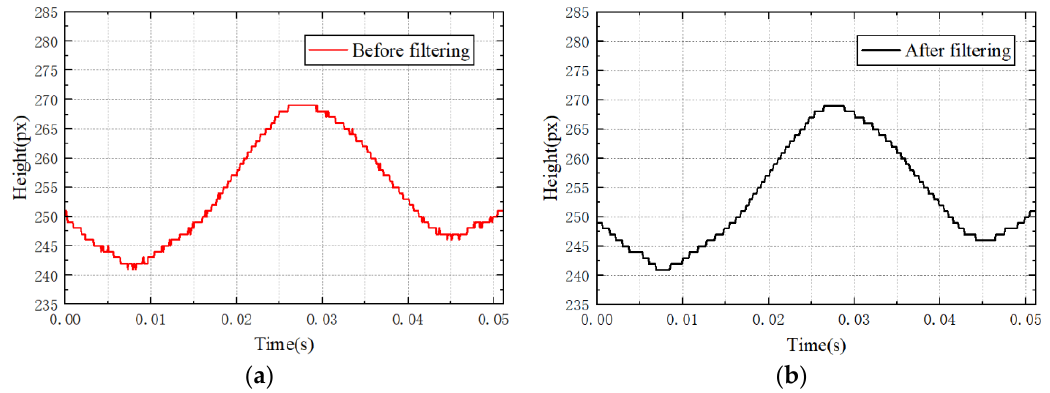
Figure 10. Yarn feature line results. ( a ) Before filtering. ( b ) After filtering.